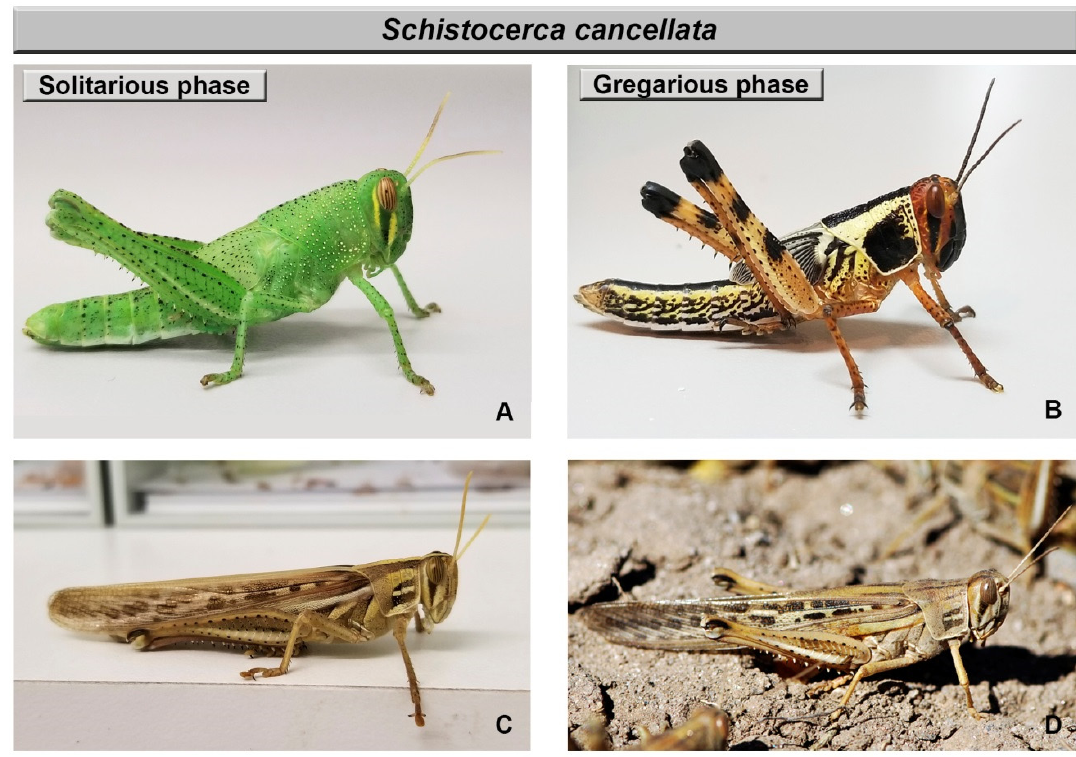
Figure 1. Schistocerca cancellata , ( A , B ) final instar nymphs and ( C , D ) adults. ( A , C ) solitarious phase (isolated locusts in laboratory); ( B , D ) gregarious phase ( B ) crowded nymph in laboratory; ( D ) adult female in nature). (Photographs: M. Pocco).